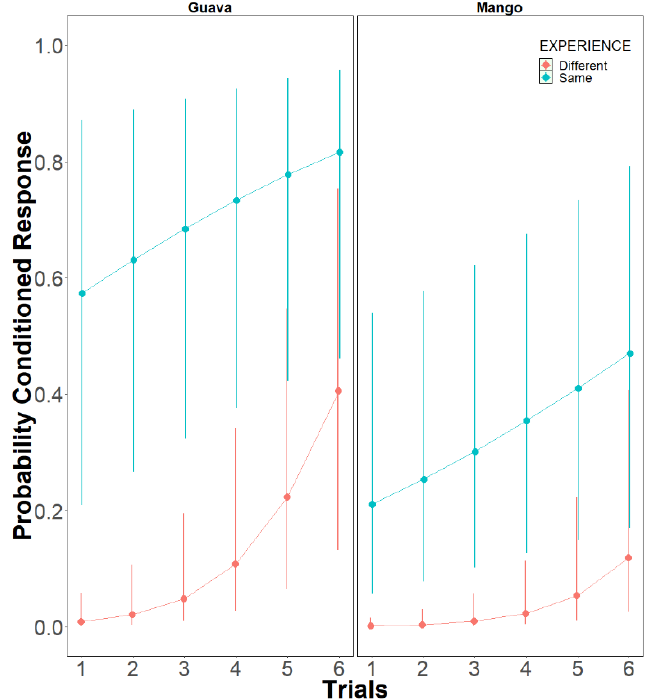
(Figure 4, Table 3; Model: Conditioned_Response ~ Trials + Experience + Odor + (1 | Bee_Total) + Trials: Experience), p < 0.0001; Supplementary Materials Table S2). The significance of these factors by levels is shown in Table 3.